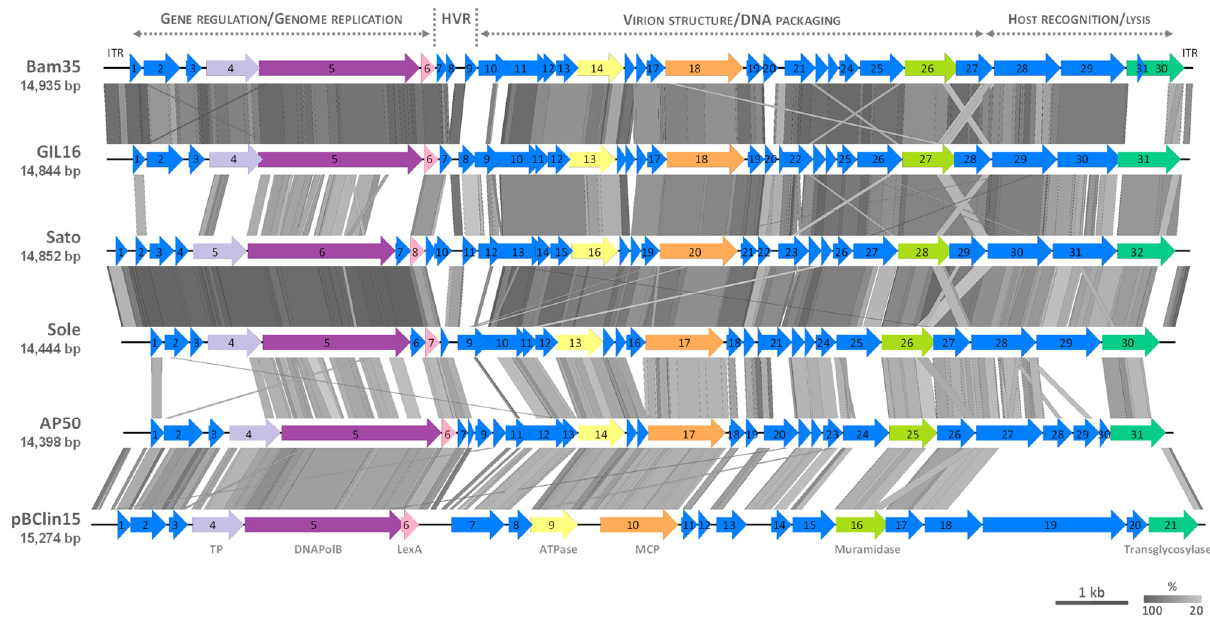
Figure 3. Genome comparisons of phages Sato and Sole with other betatectiviruses and the tectivirus-like element pBClin15. Predicted genes and direction of transcription are represented as block arrows. CDSs numbers are indicated inside the block arrows. Canonical tectiviral proteins and well conserved proteins among betatectiviruses are color-coded: light purple, terminal protein (TP); dark purple, B-family DNA polymerase (DNAPolB); rose, LexA transcriptional regulator; yellow, packaging ATPase (ATPase); orange, major capsid protein (MCP); light green, muramidase; dark green, transglycosylase. The other CDSs are in blue. ITR, inverted terminal repeat; HVR, highly variable region. Conserved regions are grey-shaded, with the color intensity indicating the percentage of amino acid identity. The comparisons were done by tBLASTx, and similarities with E values lower than 0.001 were plotted using EasyFig (v.2.1) [33]. Scale and percentage of amino acid identity are indicated at the bottom-right. Genome lengths in base pairs (bp) are indicated for each molecule. GenBank accession numbers are listed in Table 3.